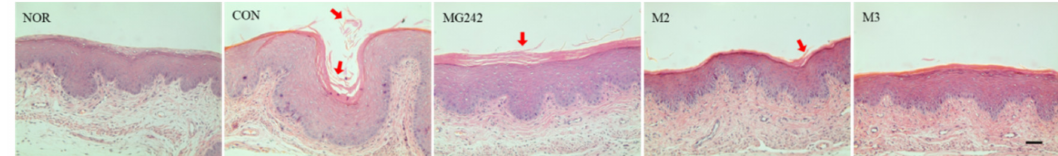
Figure 3. Histological changes in the vaginal tissues of BV-induced mice. Representative photographs of the hematoxylin and eosin (H&E)-stained vaginal tissue sections (200 × magnification, scale bar = 50 µ m). Arrows indicate exfoliated epithelial cells. NOR, normal; CON, control; MG242, Lig. salivarius MG242; M2, 1:1 mixture of Lim. fermentum MG901 and Lac. plantarum MG989; M3, 1:1:1 mixture of MG242, MG901, and MG989.